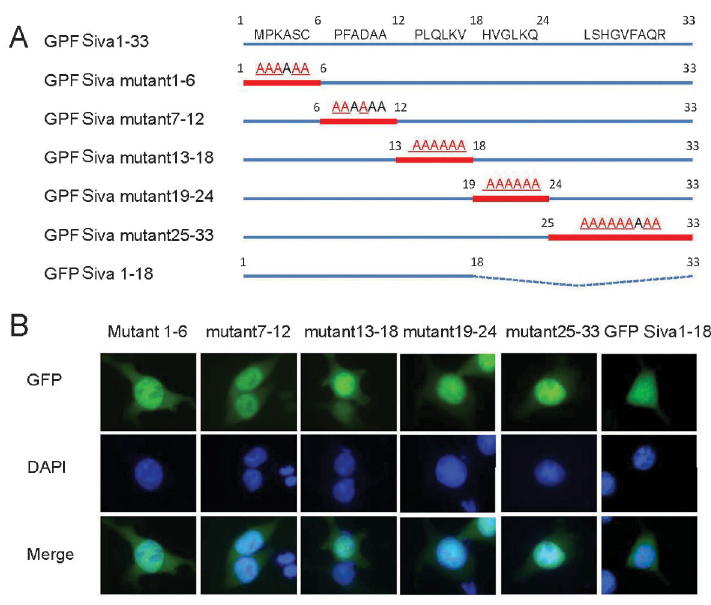
Figure 3. N-terminal amino acid residues 1-18 were necessary but insufficient for Siva-1 loca- lization in the nucleus. 293T cells transfected with green fluorescent protein (GFP)-Siva mutant1-6, GFP-Siva mutant7-12, GFP-Siva mutant13-18, GFP-Siva mutant19-24, GFP- Siva mutant25-33, and GFP-Siva1-18. Cells counter-stained with DAPI to show the location of the nuclear DNA.